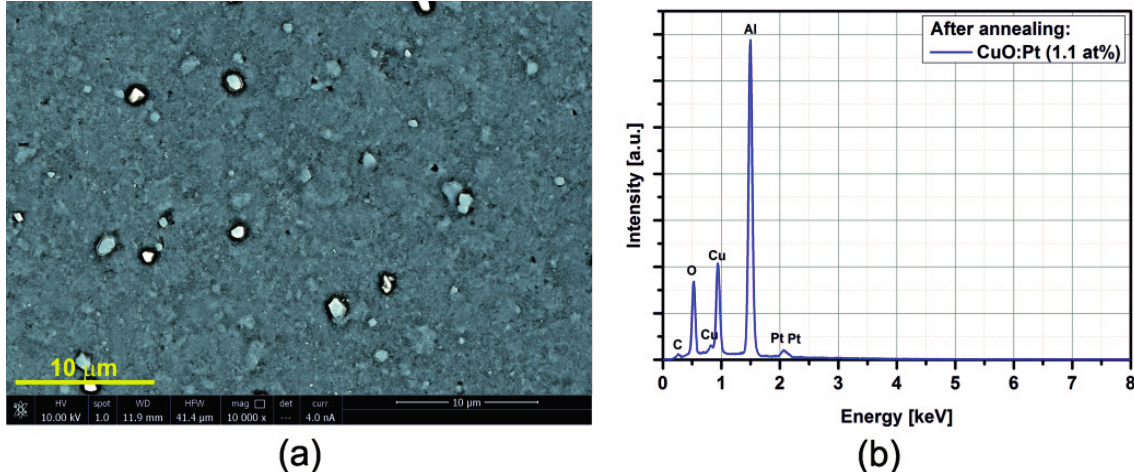
Figure 8. ( a ) SEM image; ( b ) EDX distribution of the Pd:CuO-based sensor (Pd: 2.5at%).